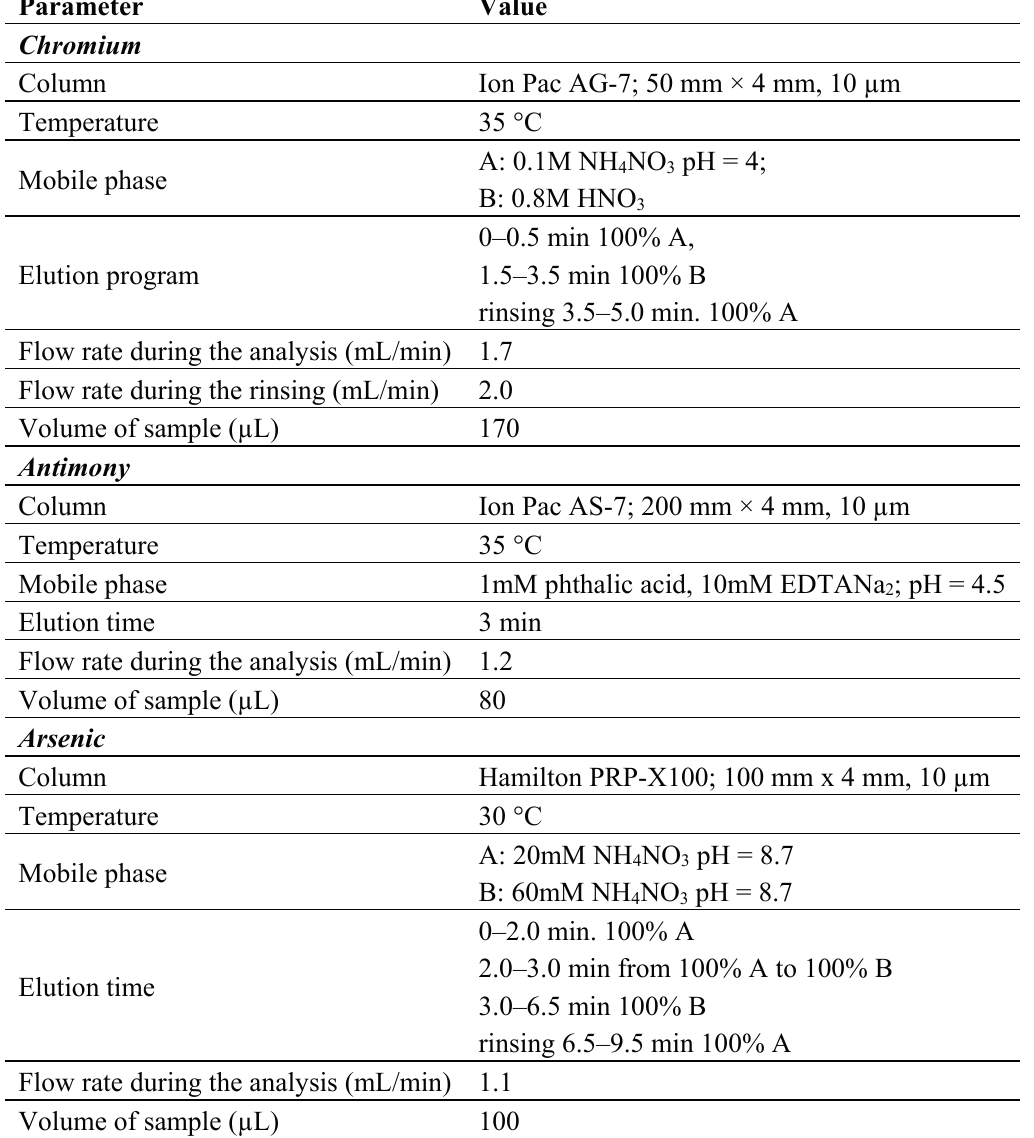
Table 3. Separation